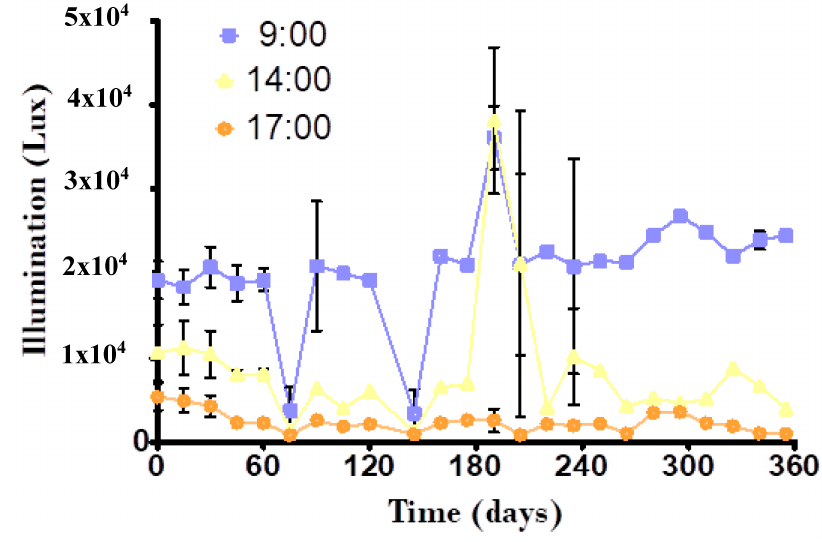
Figure 1. Intensity of light in three different times of day (9, 14 and 17 hours) during the